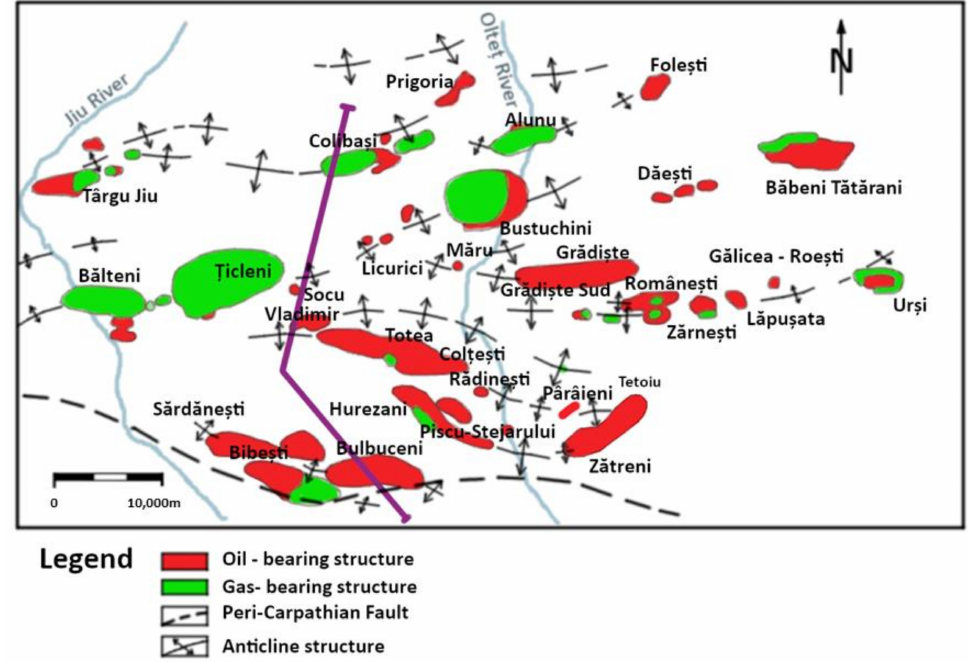
Figure 4. Map with Miocene oil and gas fields. Selected perimeter with structures and cross-section (Figure 3) of the center-southern part from the Getic Depression. (OMV PETROM S.A.-I.C.P.T. C â